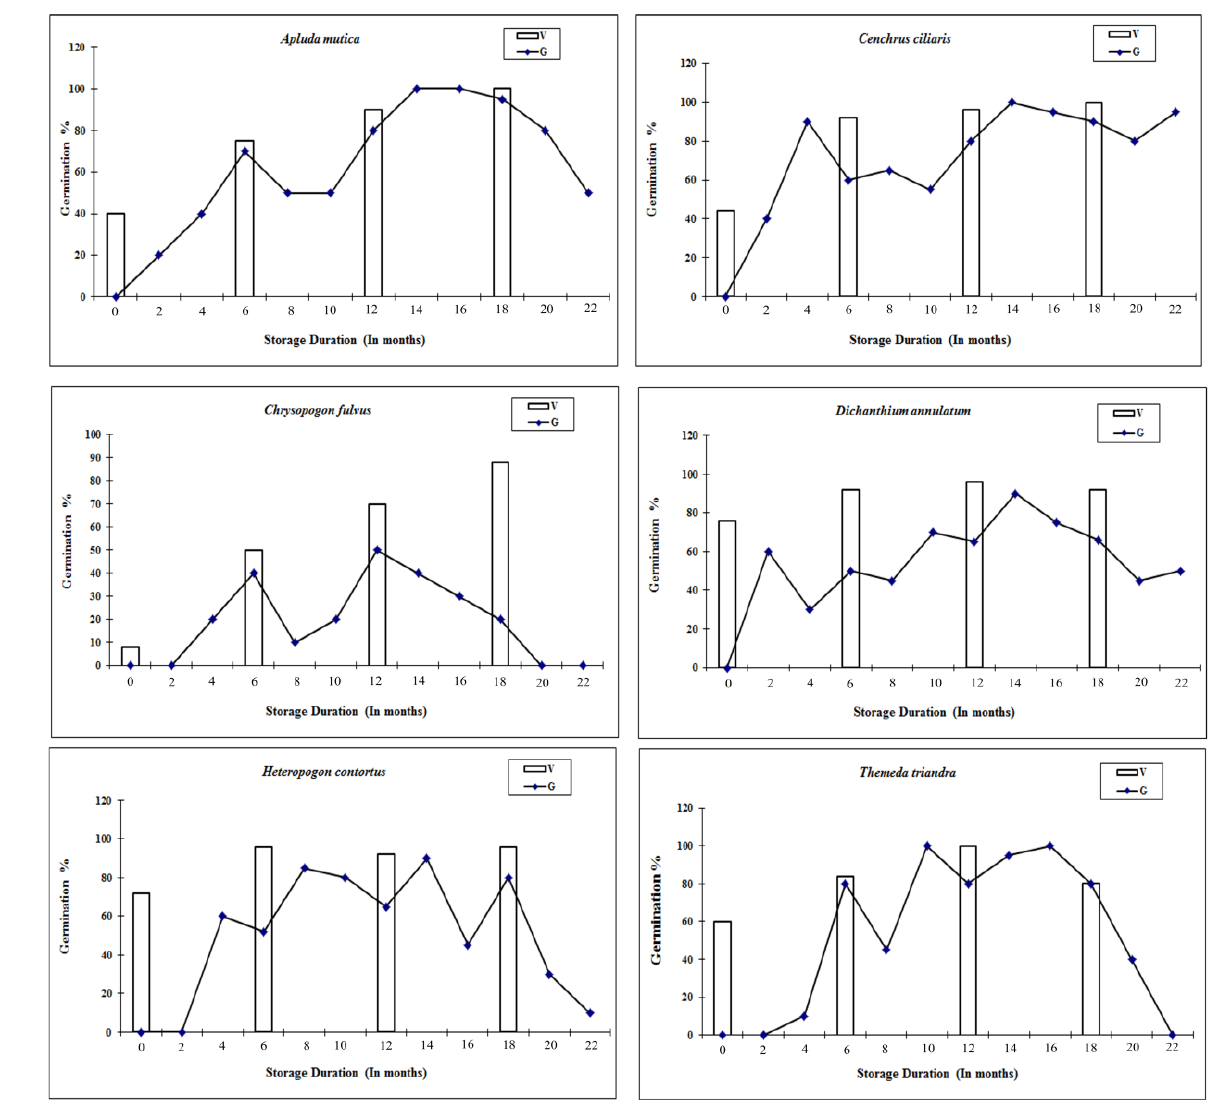
Fig. 1. Germination response against